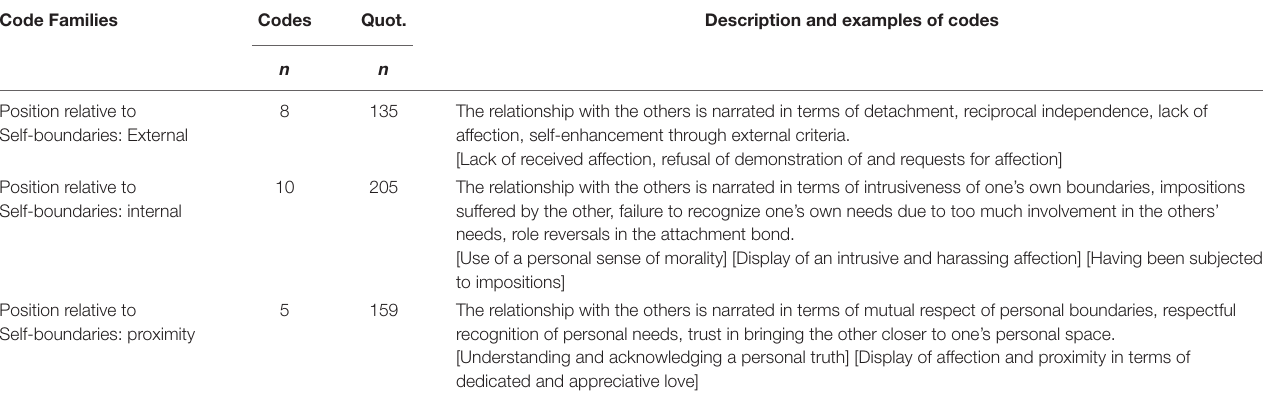
TABLE 6 | Code Families associated to the subject’s position relative to Self-boundaries. Code